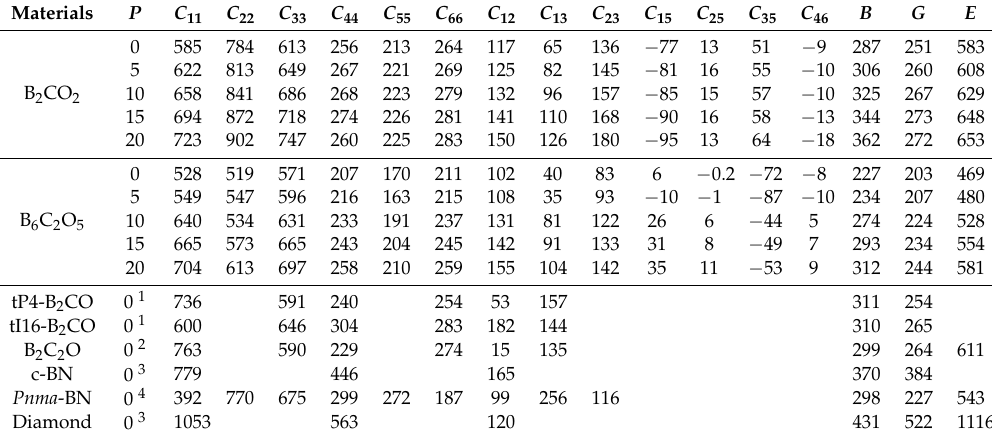
Table 2. Calculated elastic constants (GPa) and elastic modulus (GPa) of B 2 CO 2 and B 6 C 2 O 5